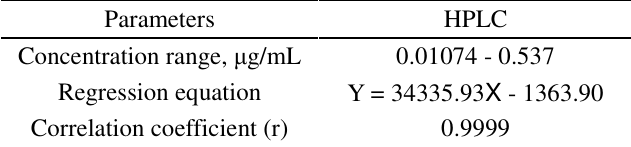
Table 2. Results of the data analysis for the linearity of citrinin